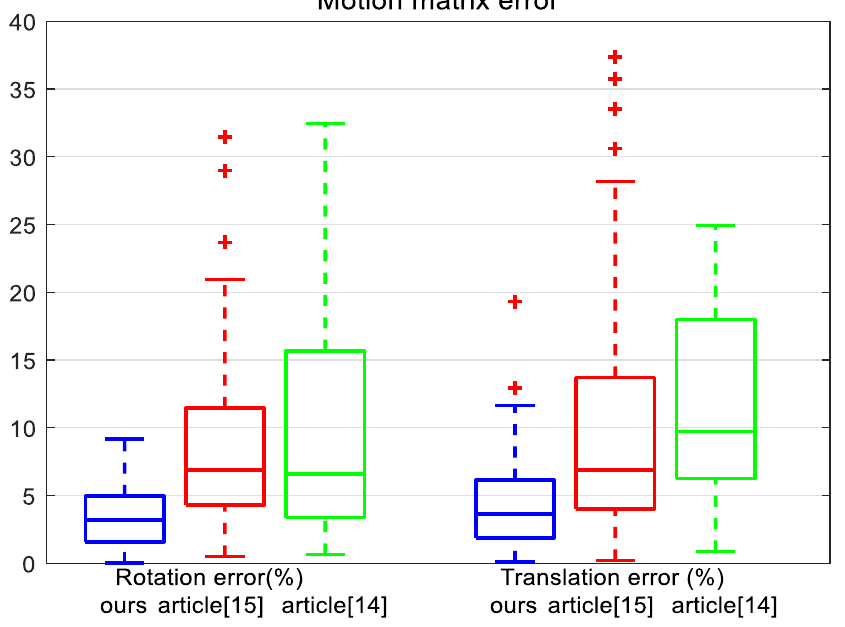
Figure 6. Comparing the accuracy of our approach method, the method of [14], and the method of